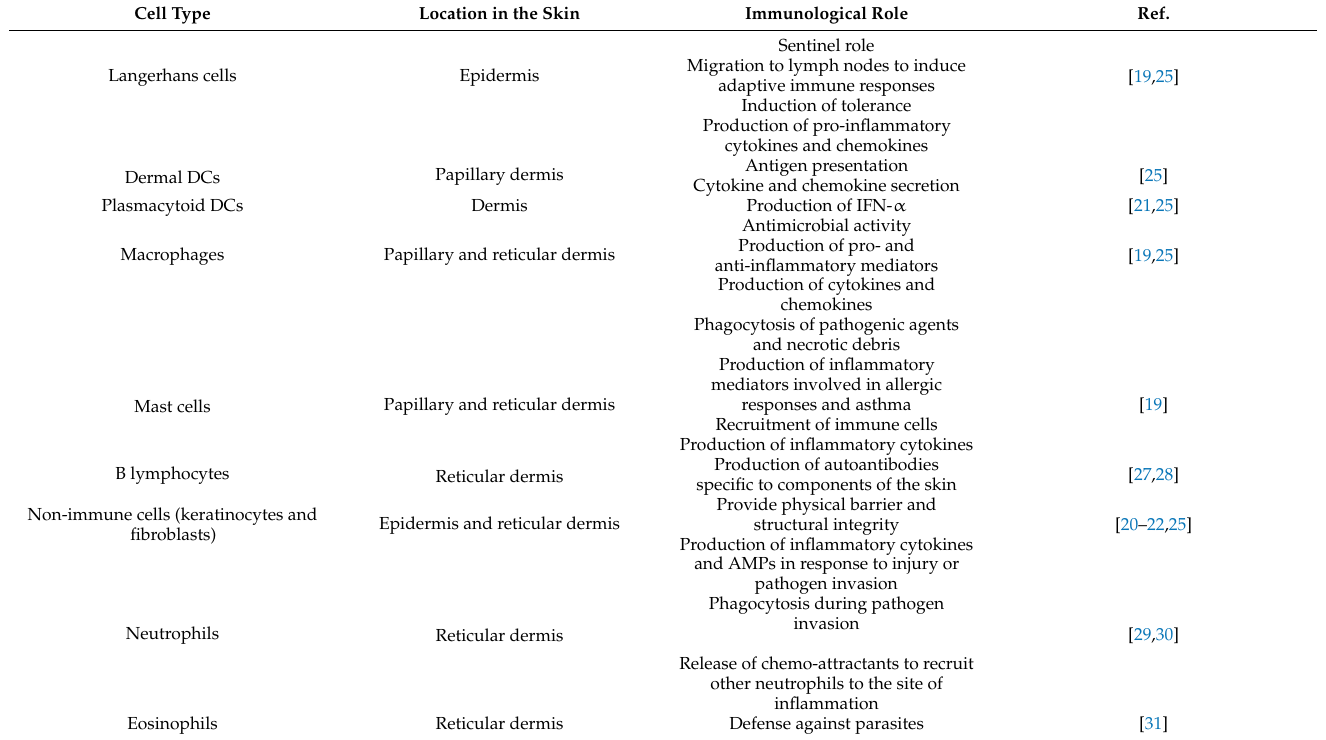
Table 1. Main immunological functions of skin